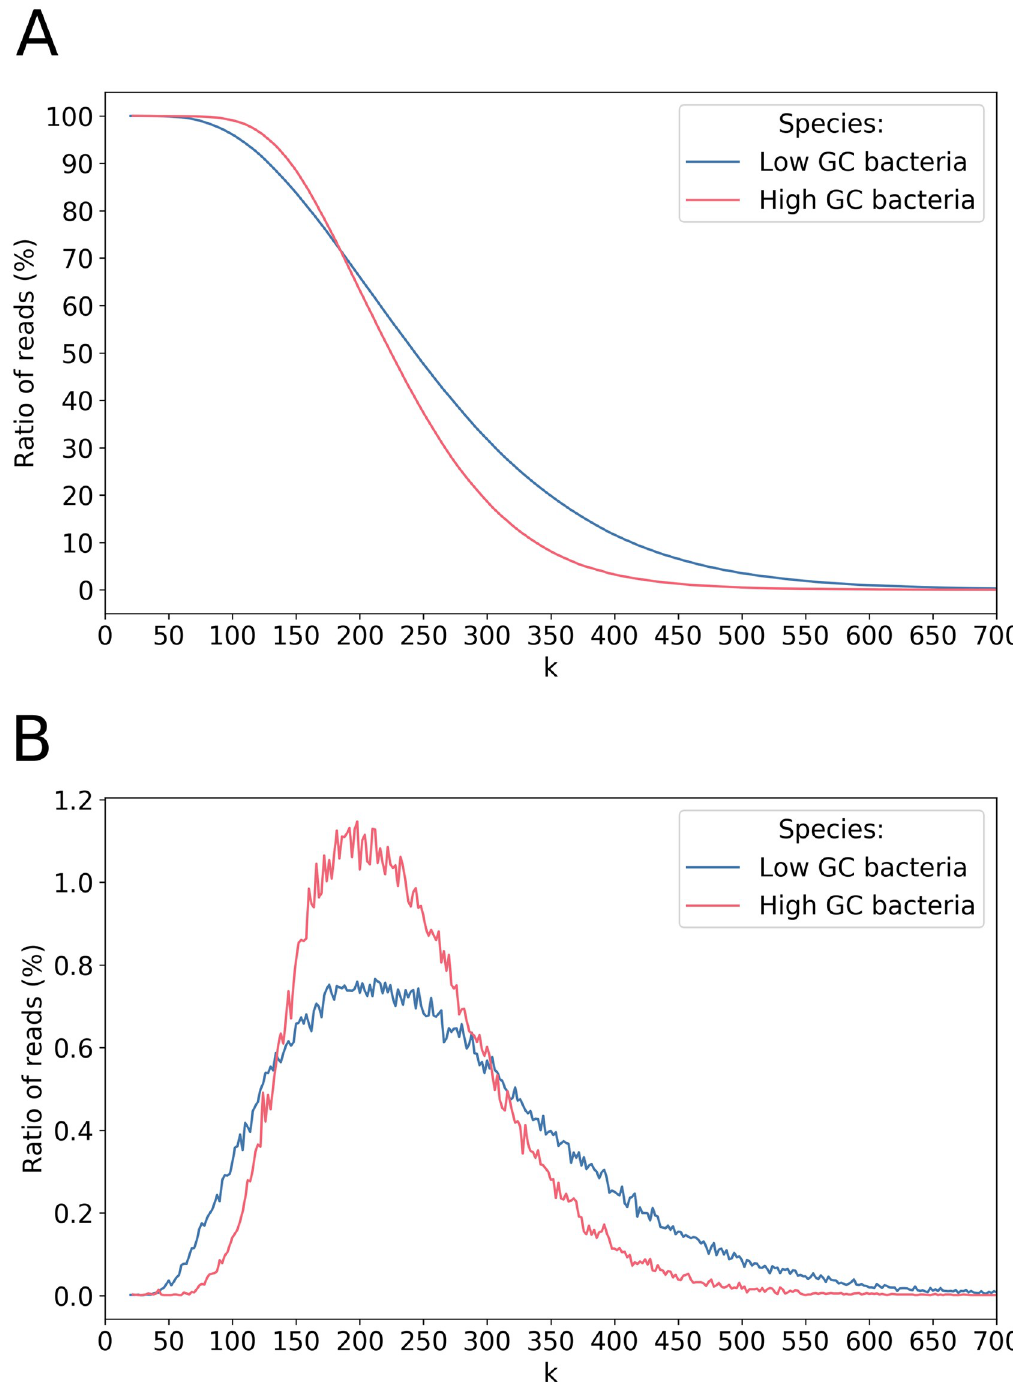
Fig 13. Analysis of perfect k-mers for bacterial data. Species are gathered based on their GC content.